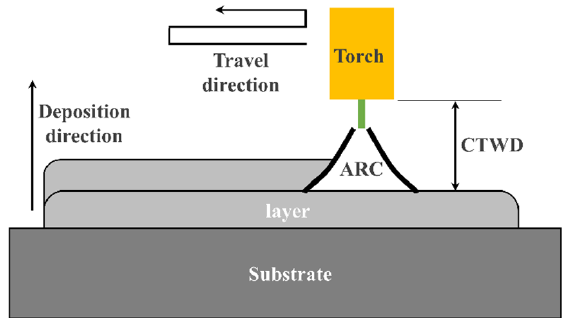
Figure 2. Schematic illustration of experimental variable.